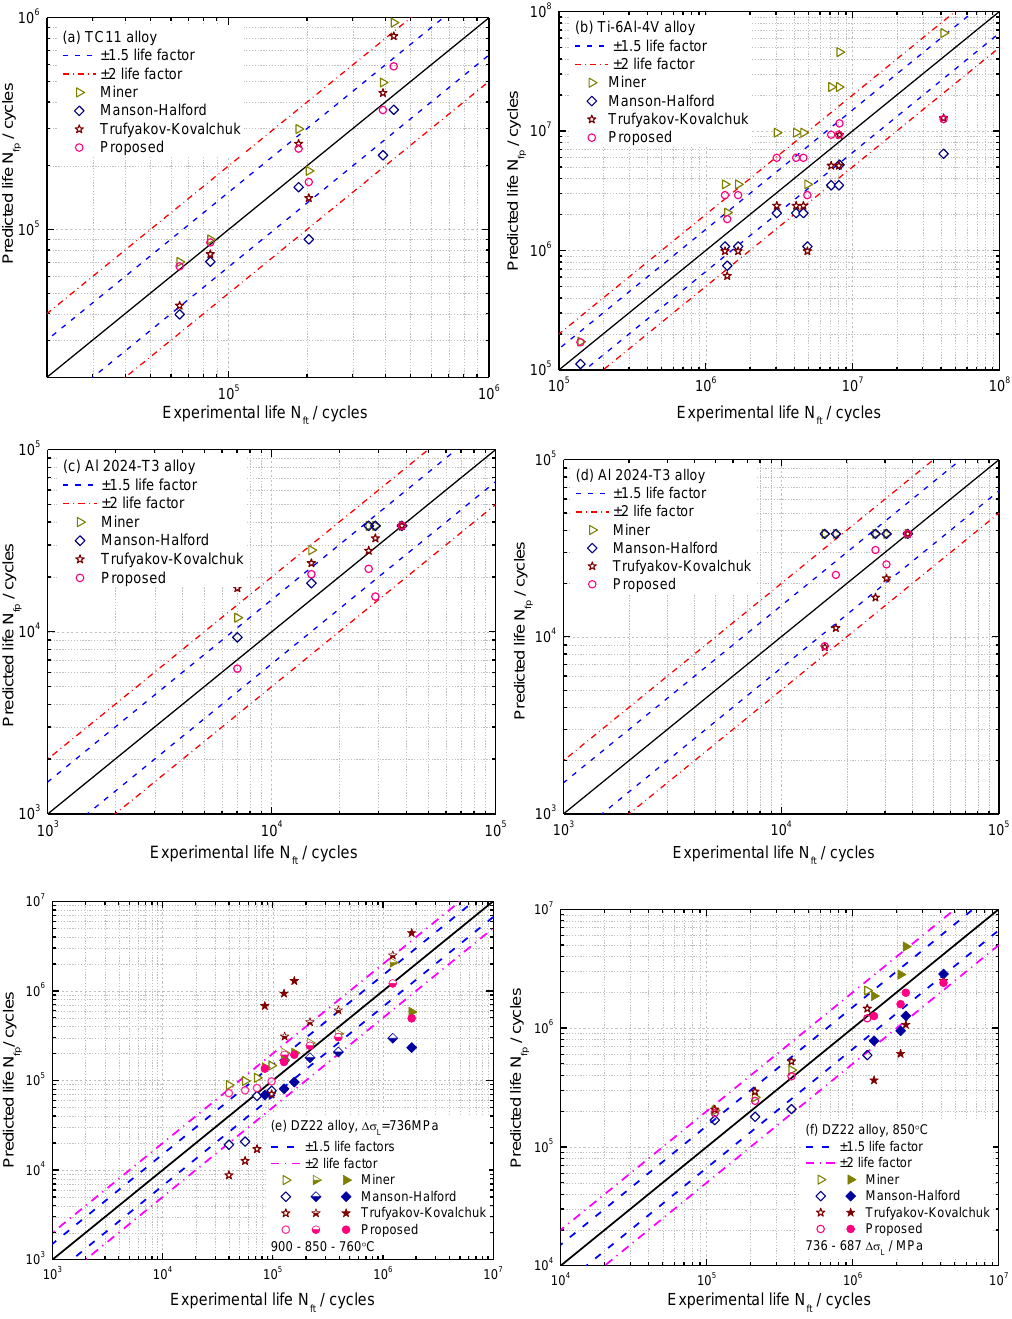
Figure 5. Comparison between experimental results and model predictions of ( a ) TC11; ( b ) Ti-6Al-4V, ( c ) Al 2024-T3 for different 𝛼 ; ( d ) Al 2024-T3 for different 𝑛 ; ( e ) DZ22 alloy for different temperatures and ( f ) DZ22 alloy for different ∆𝜎 𝐿 .